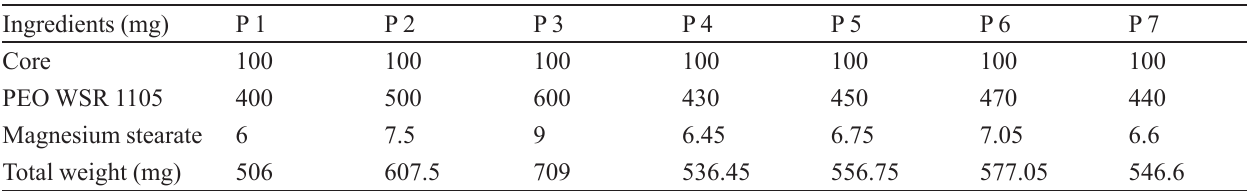
TABLE III - Coated tablet composition of PEO WSR 1105